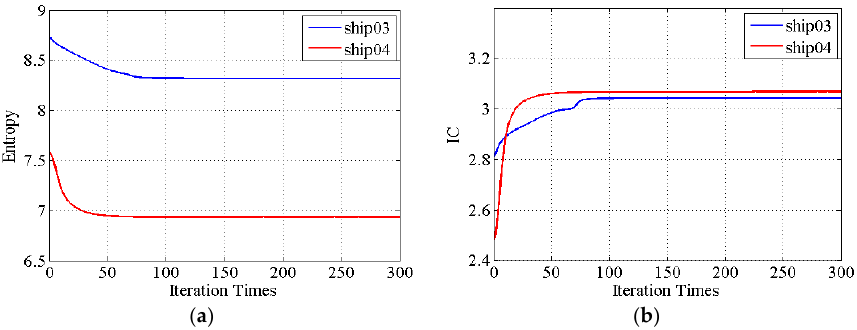
Figure 13. The entropies and IC values convergence of two sub-images versus the number of iterations. ( a ) Entropy change of the two sub-images during iteration. ( b ) IC values change of the two sub-images during iteration.